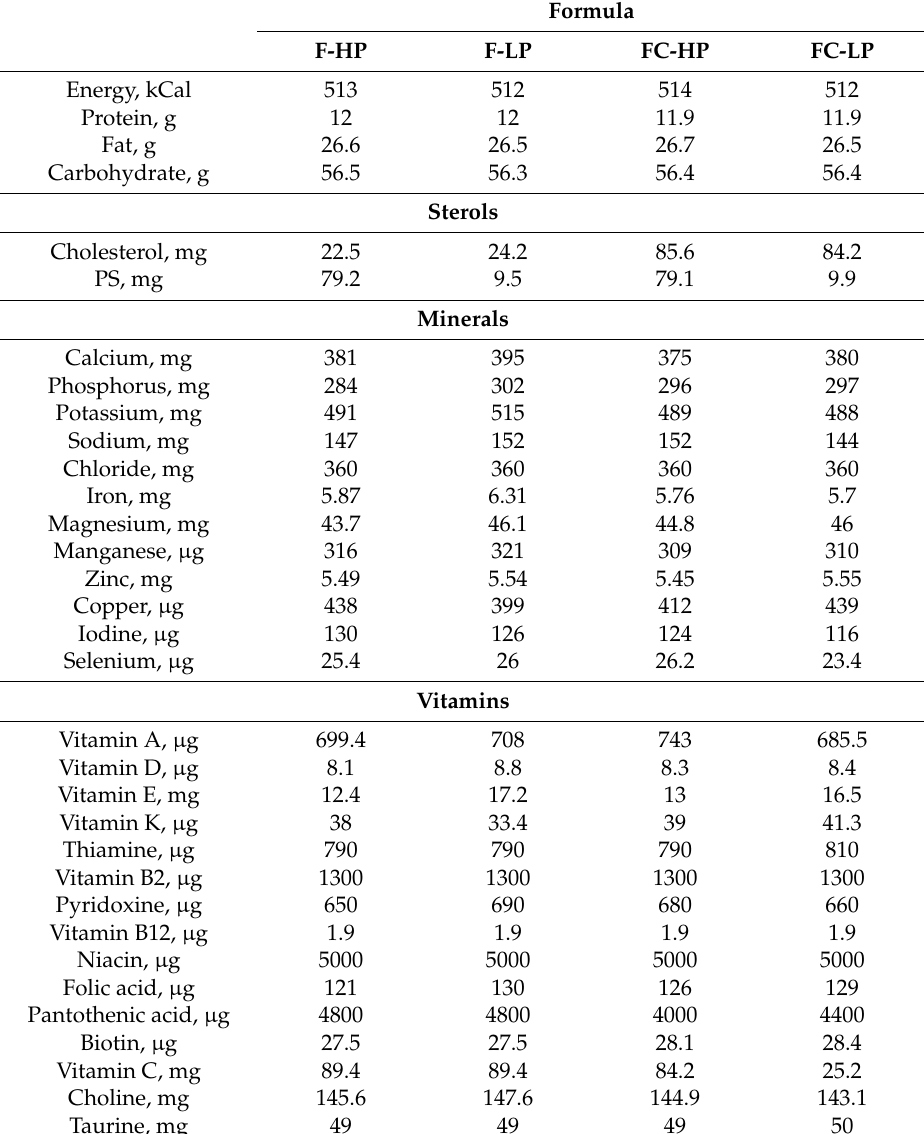
Table 1. Diet composition of the four experimental infant formulas: F-HP, F-LP, FC-HP, and